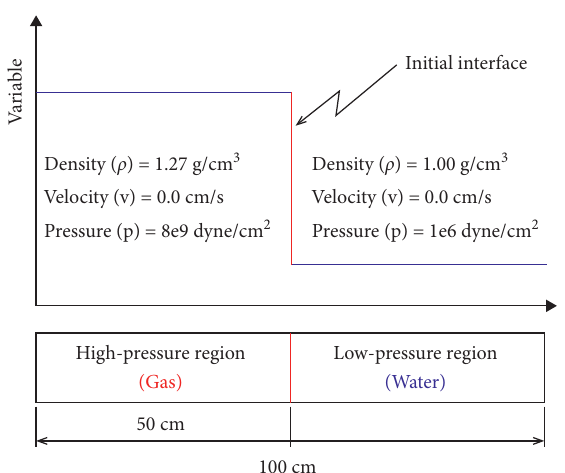
Figure 5: Initial conditions of Case